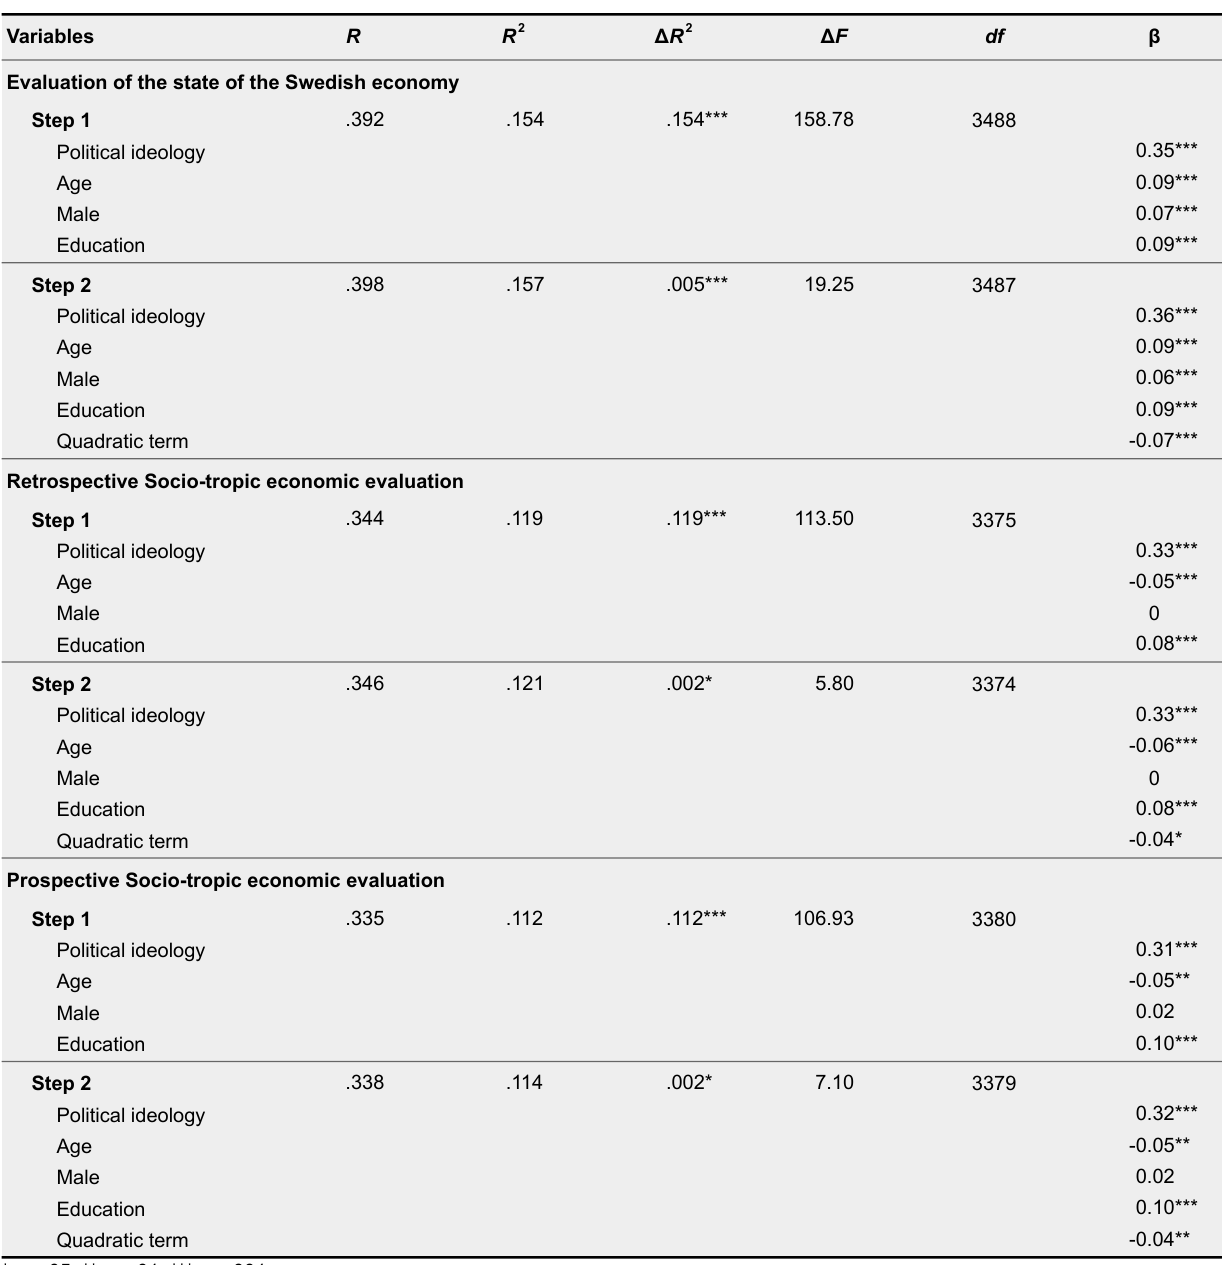
Determinants Explaining Economic